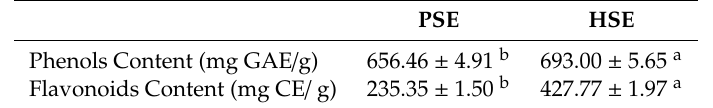
Values represent a mean ± standard deviation, n = 3. Di ff erent letters in the same line indicate significant di ff erences ( p < 0.05). Tukey´s test. GAE: Gallic acid equivalents, CE: catechin equivalents, PSE: pecan nutshell extract, HSE: hazelnut skin